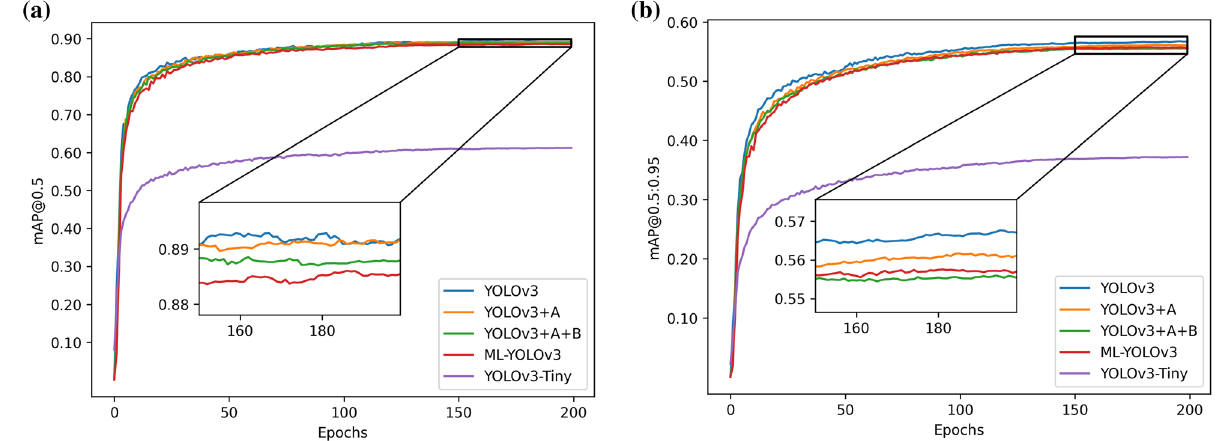
Figure 13. The comparison results between our improvement and YOLOv3 and YOLOv3-tiny in terms of the detection effect.